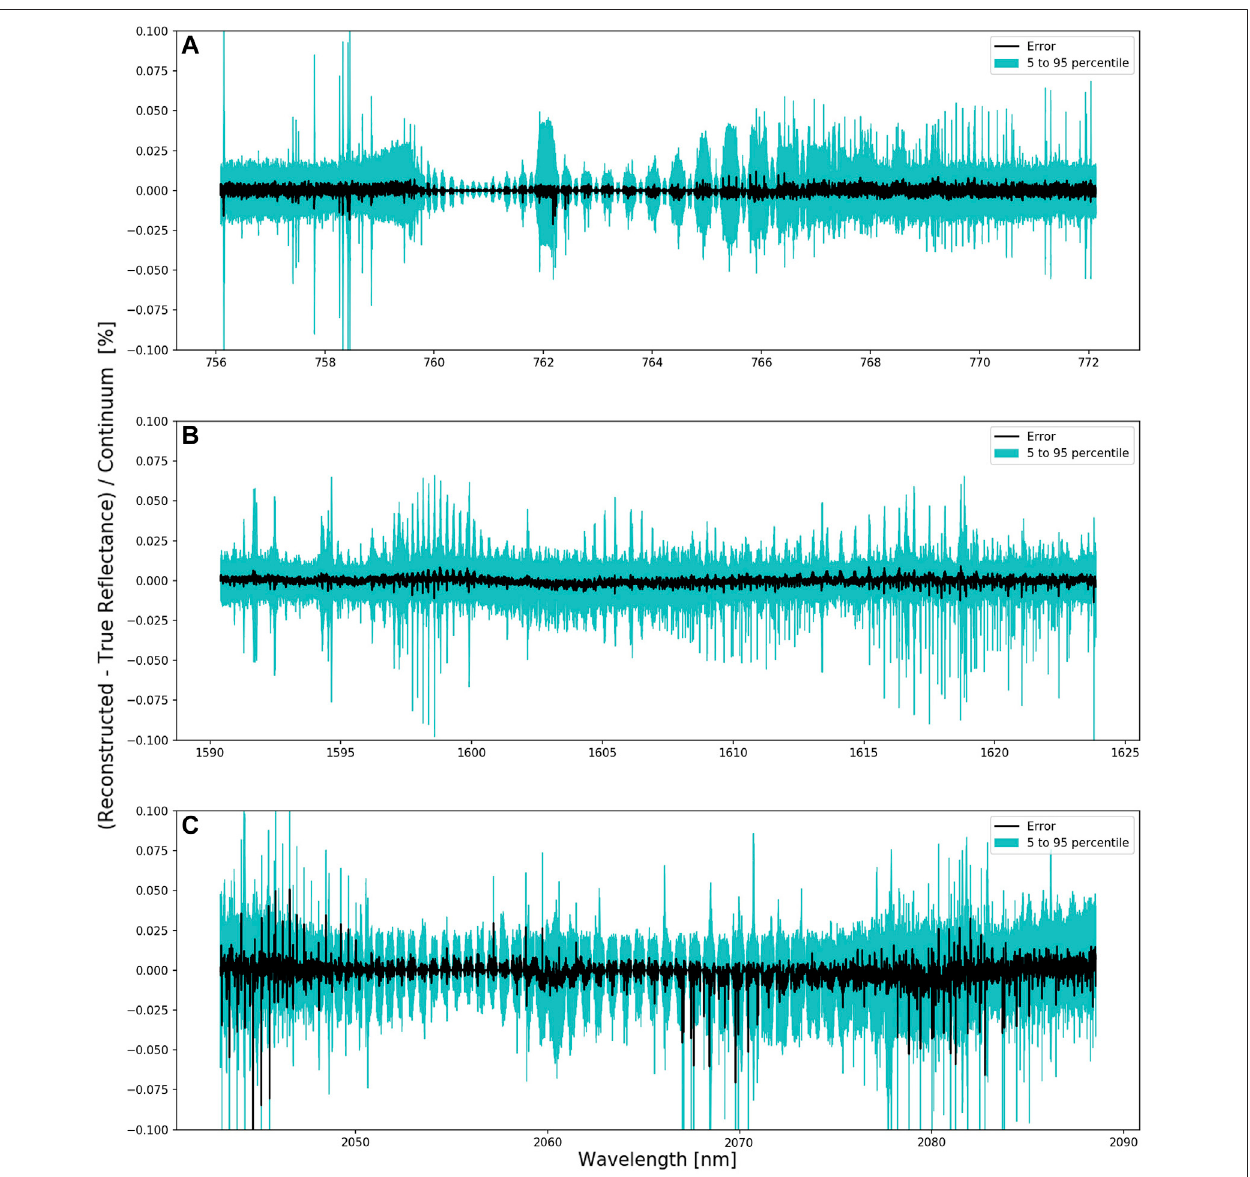
FIGURE 8 | Modeling error over the full testing set for each wavelength of the O2A-band (A) , WCO2-band (B) , and SCO2-band (C) . The mean error is shown in black, the 5th to 95th percentile is shown in turquoise.